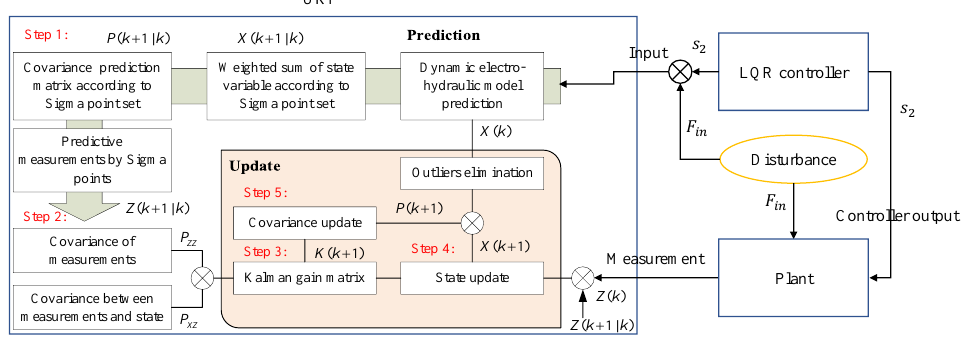
Figure 10. The topology of UKF